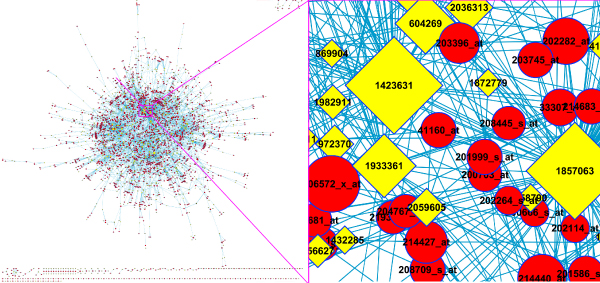
Gene-SNP intermixed network. The size of each node is scaled by its degree of connectivity. Hub nodes thus are readily viewed due to their larger size.